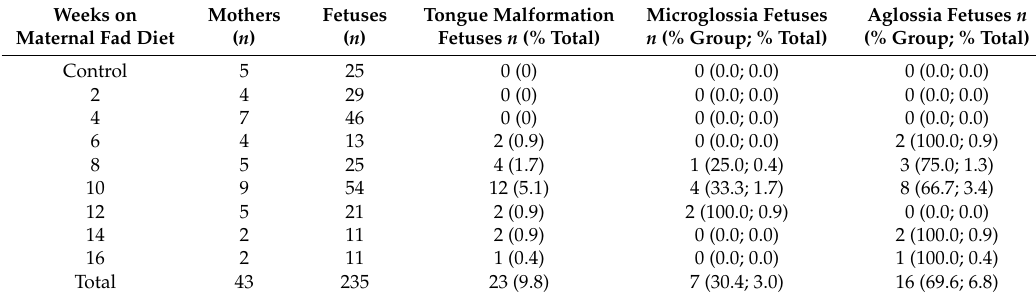
Table 1. General outcome. Number of fetuses and type and incidence of malformation with respect to weeks on a maternal folic acid-deficient (FAD)